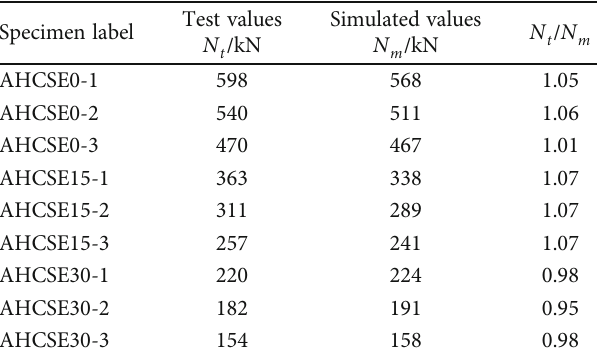
Figure 12: Specimen load-displacement curve: (a)AHCSE0-1; (b)AHCSE0-2; (c) AHCSE0-3; (d) AHCSE15-1; (e) AHCSE15-2; (f) AHCSE15-3; (g) AHCSE30-1; (h) AHCSE30-2; (i) AHCSE30-3. Table 5: Comparison of test values and fi nite element calculated values.